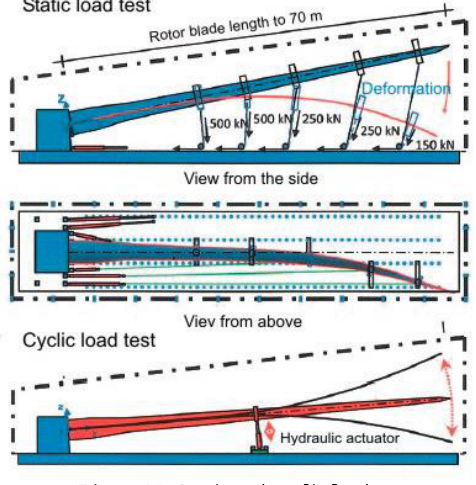
Figure 25: Static and cyclic load